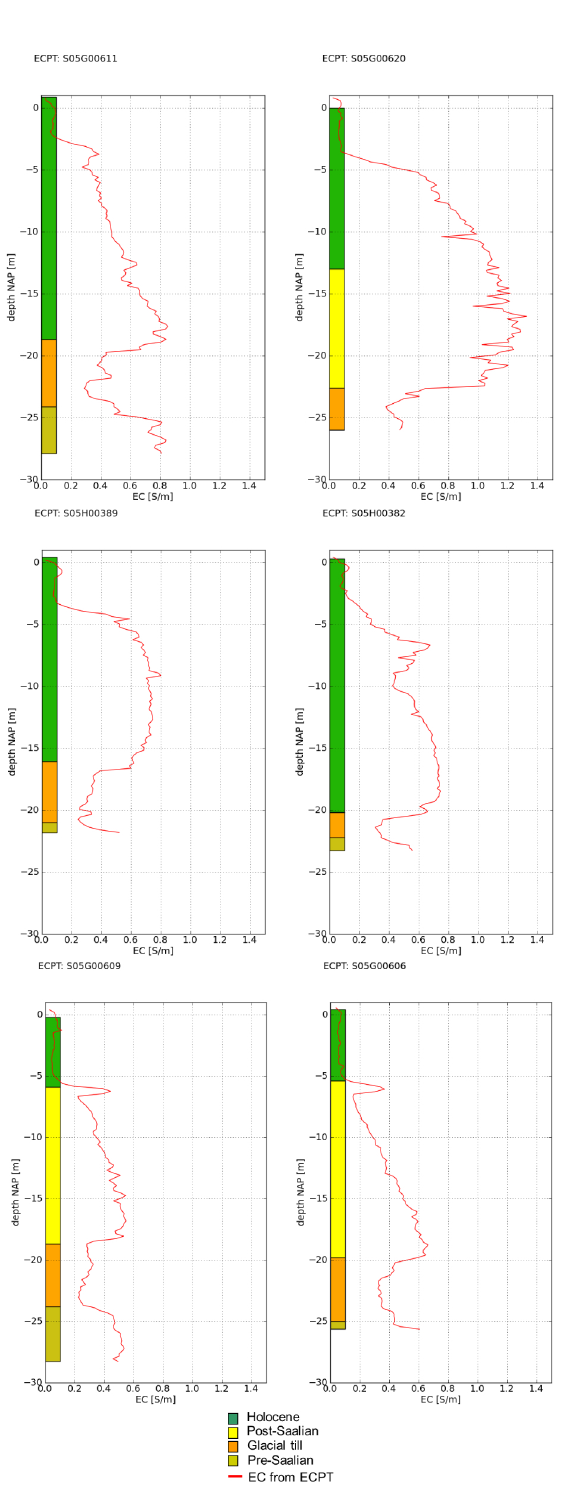
Fig. 3. Geological variation and EC, as derived from ECPT.